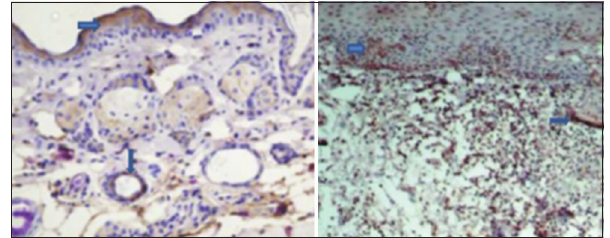
Figure-3: Immunohistochemistry image showing the extent of VEGF expression in skin of diabetic rats (left) and control rats (right). Arrows point at brown color indicating of VEGF (40×). There was a significant difference in the expression of VEGF in the skin of control rats when compared that in alloxan-induced diabetic rats. VEGF=Vascular endothelial growth